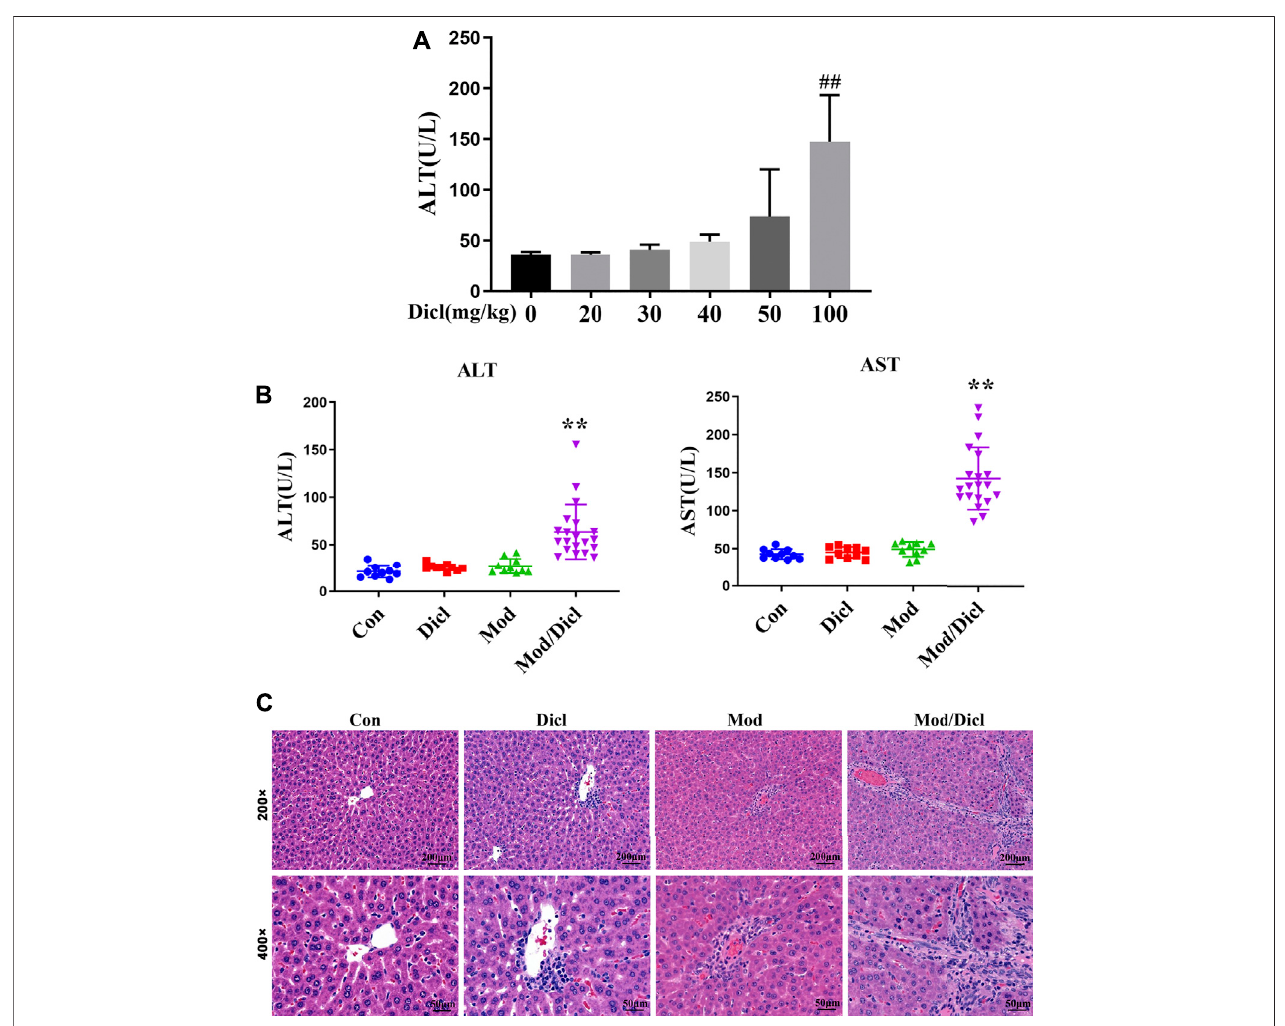
FIGURE 2 | Phenotypes of Dicl-IDILI in normal rats or model rats with modest in fl ammation. (A) Dose-responsive liver injury phenotype of Dicl exposure in normal rats. Dicl doses ranged from 0 to 100 mg/kg (i.p.) (n (cid:1) 6, ## p < 0.01 vs . control). (B) The liver injury phenotype of Dicl (20 mg/kg, i.p.) exposure in rats with modest in fl ammation. Con (n (cid:1) 10), the control group; Mod (n (cid:1) 10), the non-toxic dose ofthe LPS-induced modest in fl ammation model group; Dicl (n (cid:1) 10), normal rats treated with a low dose of Dicl (20 mg/kg, i.p); Mod/Dicl (n (cid:1) 20), the modest in fl ammation model of rats treated with a low dose Dicl (20 mg/kg, i.p). The results are expressed asmean ± SD, andsigni fi cantdifferences areindicated( pp p < 0.01, vs. Mod). (C) Histologicalalterations inratlivers amongthe differentgroups (H&Estained, × 200 and × 400 magni fi cation).